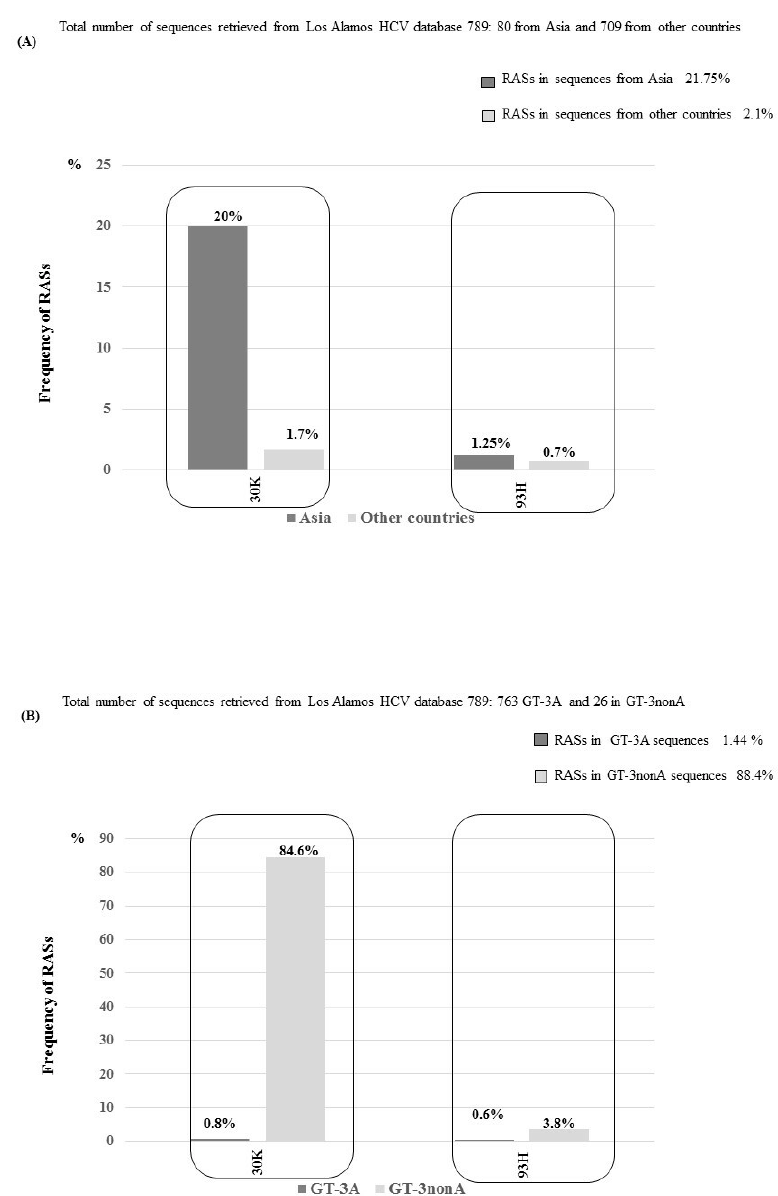
Figure 7. Frequencies and geographic distributions of the A30K and Y93H substitutions in the NS5A region. ( A ) Frequencies of A30K and Y93H according to geographic origin of isolates (Asia vs. other countries). ( B ) Frequencies of A30K and Y93H according to GT-3 subtype (GT-3A vs. GT-3nonA). Table 2. Mean fold change in resistance compared to wild-type replicon of RASs detected in GT-3a sequences retrieved by Los Alamos HCV database. RASs Replicative Capacity DCV ◦ FC